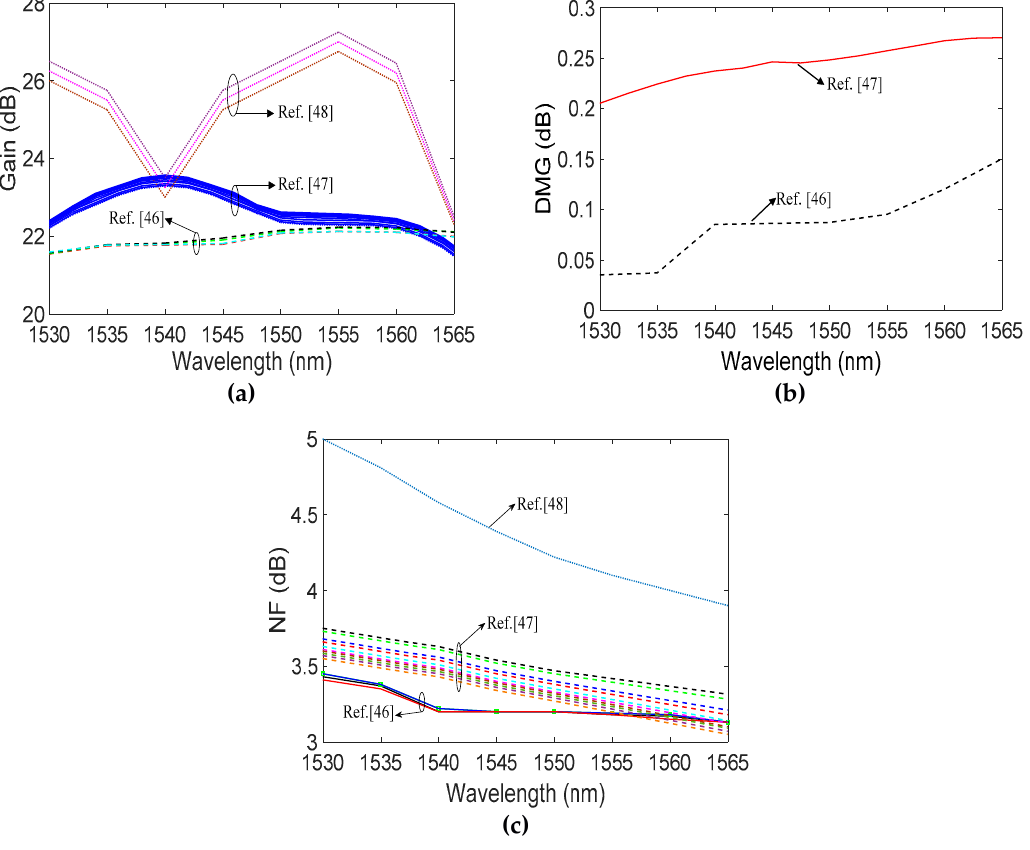
Figure 7. ( a ) The gain; ( b ) noise figure (NF); and ( c ) the differential mode gain (DMG) as a function of wavelength for different OAM EDFA (Data from Ref.[46–48]).